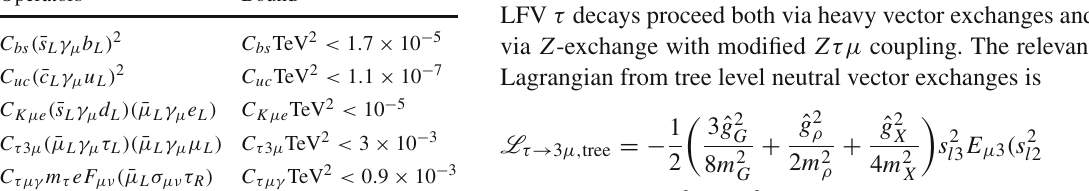
Table 2 Relevant constraints from low energy flavor data